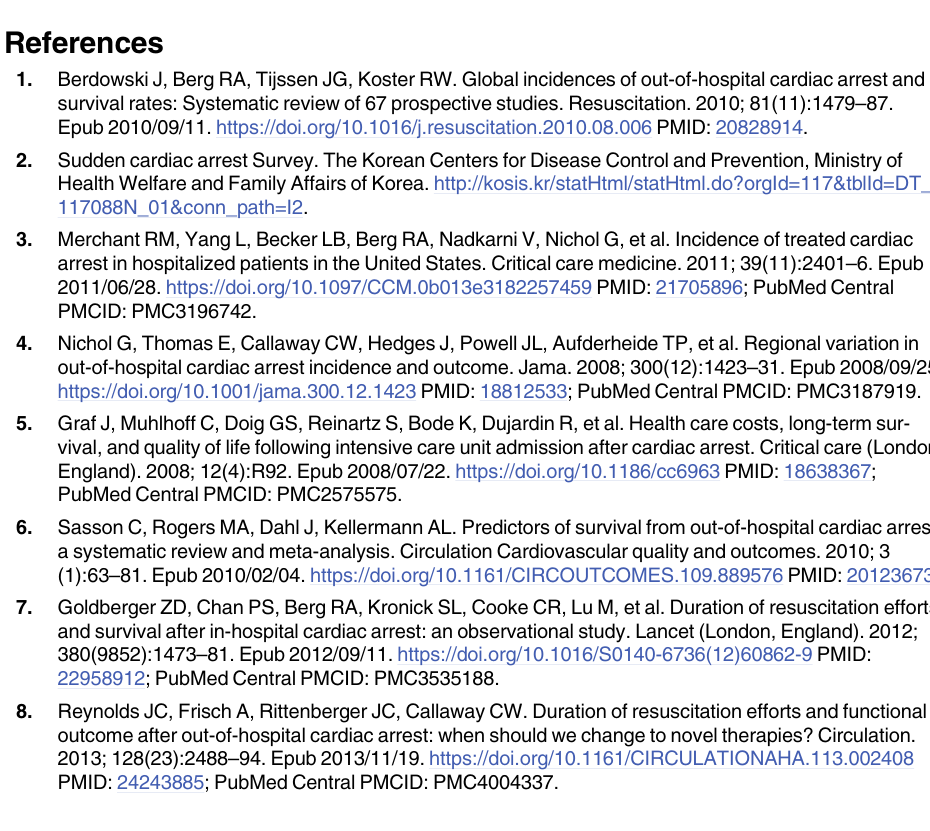
S2 Table. The characteristics, comorbidities, and mortality between both groups by admis- sion